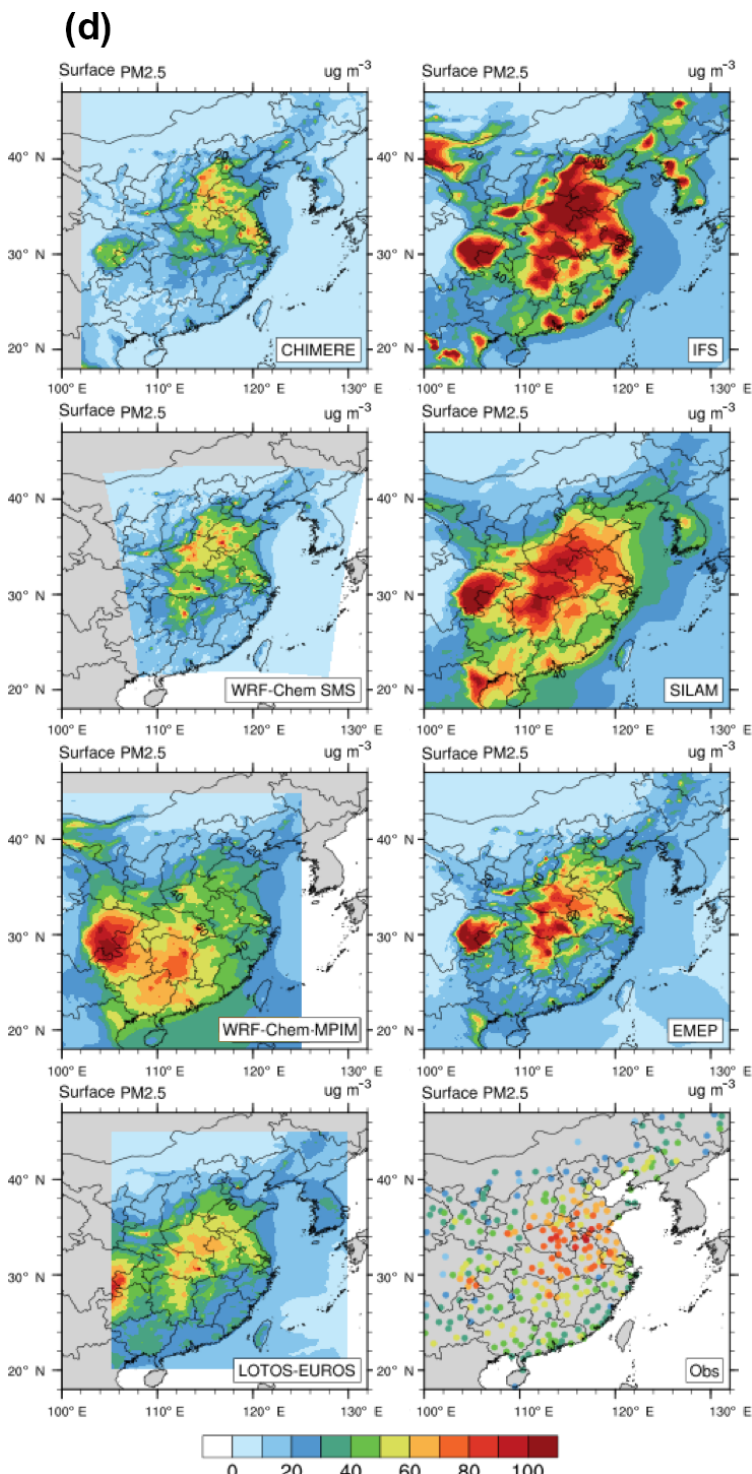
Figure 7. Monthly mean surface concentrations of (a) CO, (b) NO 2 , (c) ozone (ppbv), and (d) PM 2 . 5 (µgm − 3 ) provided for the month of March 2017 by different models: CHIMERE (no CO), IFS, WRF-Chem-SMS, SILAM, WRF-Chem-MPIM, EMEP, and LOTOS-EUROS. The monthly mean concentration values derived from observations at different monitoring stations are represented by dots in the last plot of the bottom panel. The adopted color scales are the same as the color scales adopted to represent the model